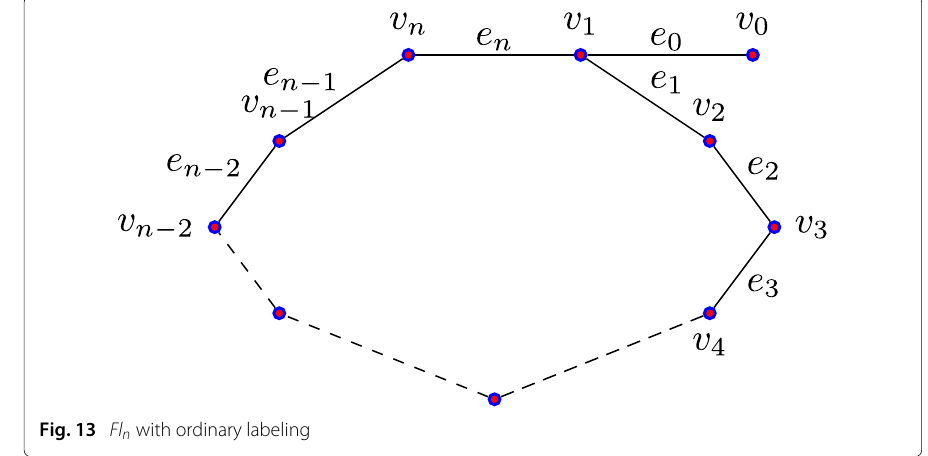
Fig. 13 Fl n with ordinary labeling